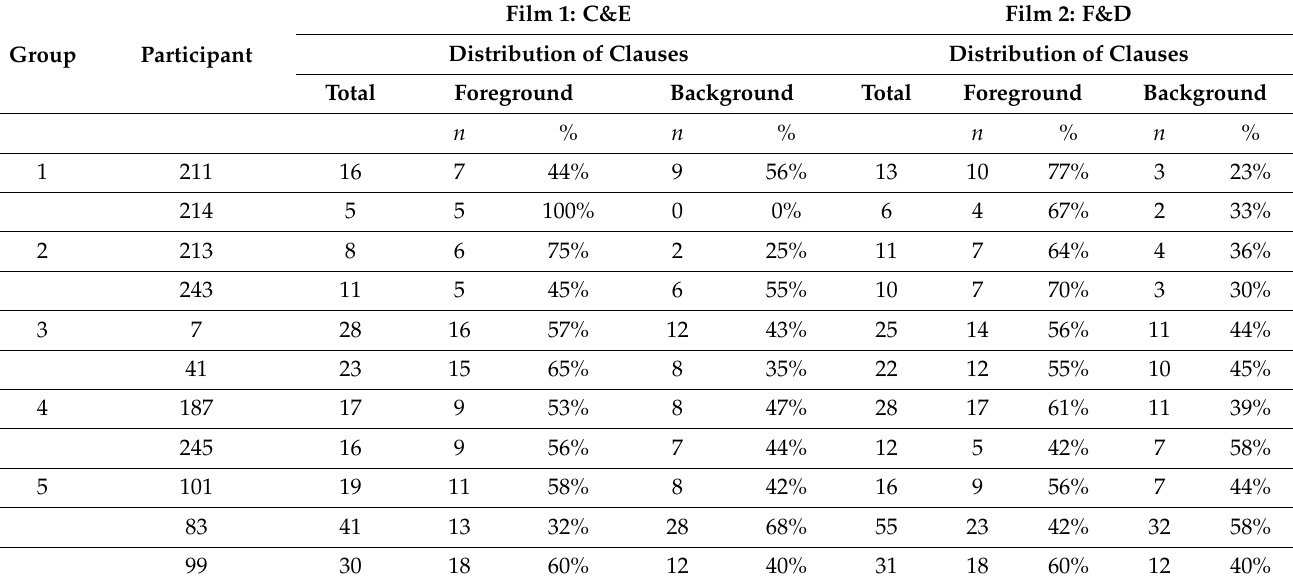
Table 3. Proportions of clauses in the foreground and